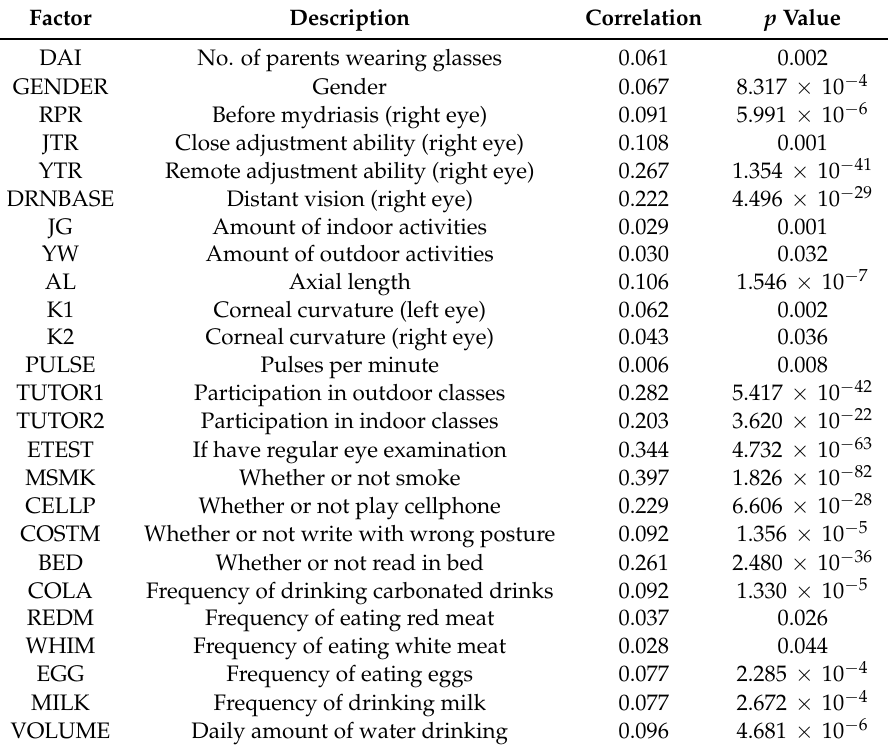
Table 1. Results of univariate correlation